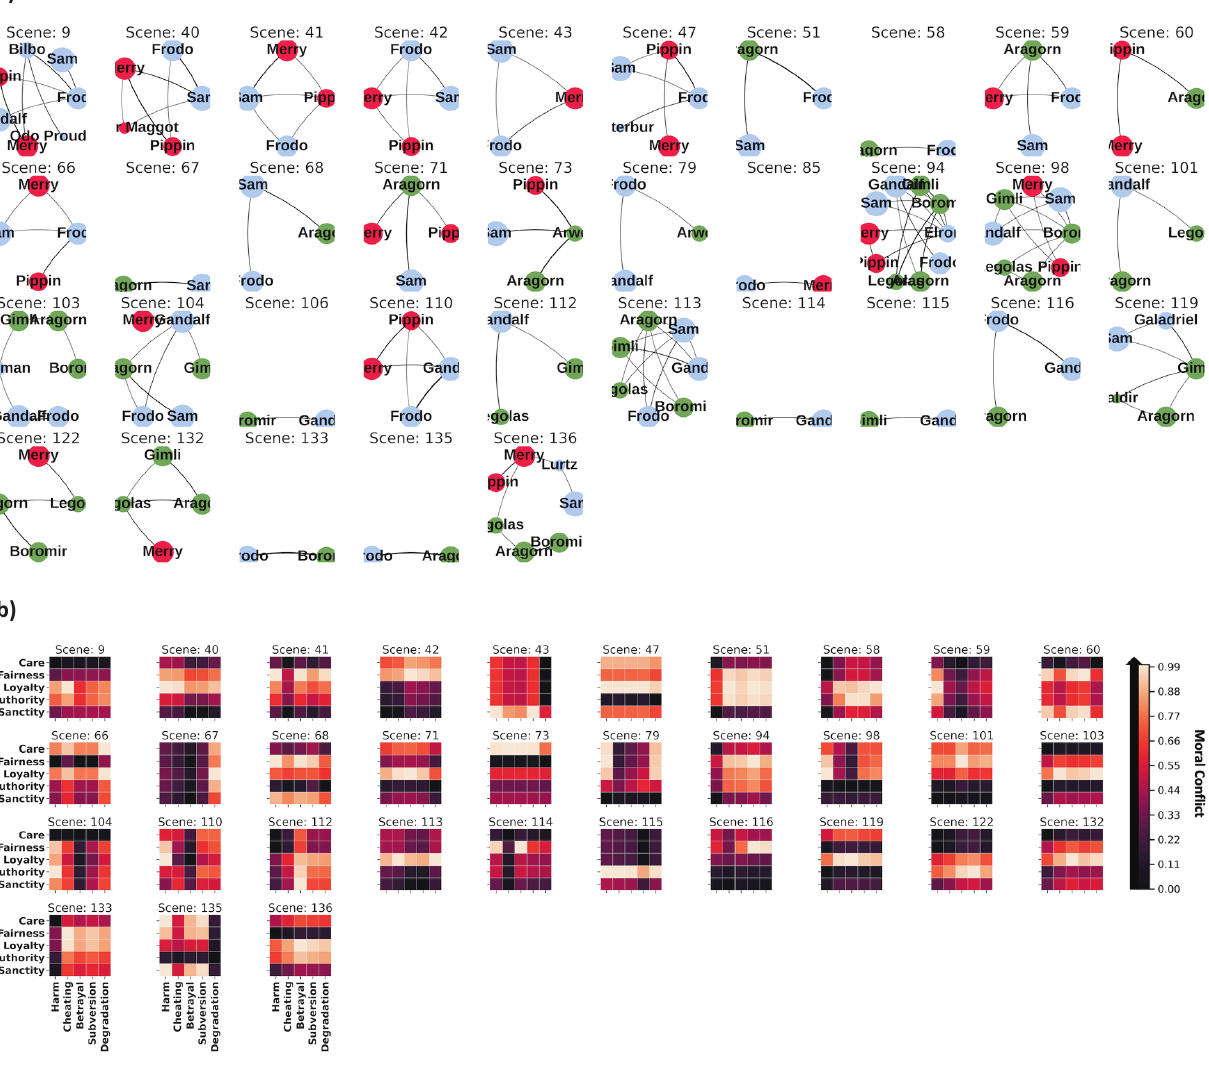
Figure 7. Moral conflict in The Lord of the Rings: The Fellowship of the Ring : (a) Cross-module scenes and character interac- tion networks; (b) Moral conflict matrices. Notes: Two cross-module scenes (85 and 106) were discarded for moral conflict computations as no moral content was identified. Source: